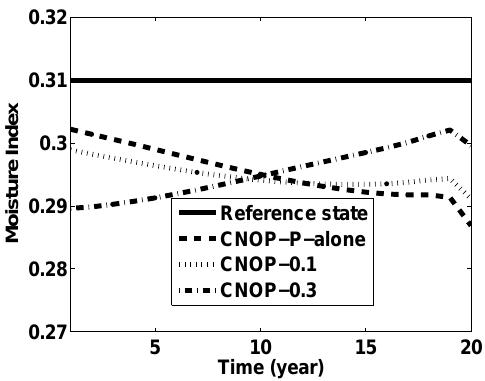
Fig. 1. Fig. 1. The variations in the moisture index when δ 2 = 0 . 22 and the annual perturbations have been superimposed on the reference moisture index. CNOP-P-alone implies the moisture index as a pa- rameter being optimized the Eq. (7) alone. CNOP-0.1 and CNOP- 0.3 imply the parameter perturbation of the CNOP obtained when δ 1 = 0 . 1 and δ 1 = 0 . 3 by optimizing the Eq. (3).